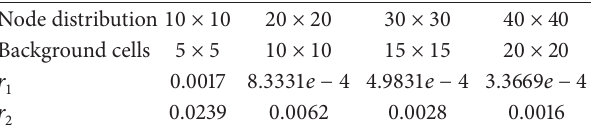
Table 4: Convergence study for Example 4.2